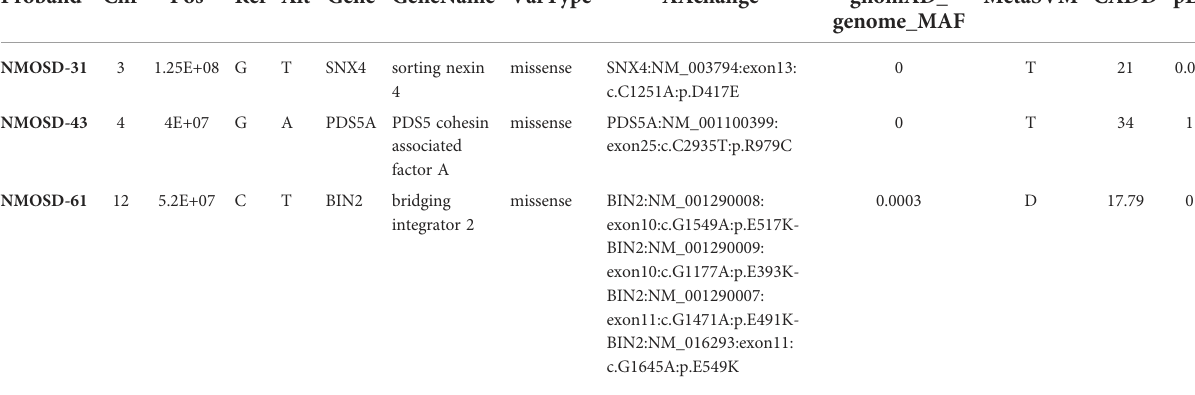
TABLE 4 De novo variants identi fi ed in patients with